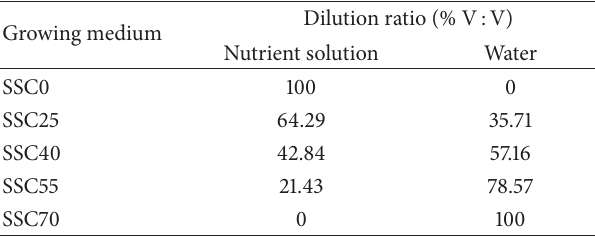
Table 7: Dilution ratio of nutrient solution supplied to the growing media from 1 to 90DAT.